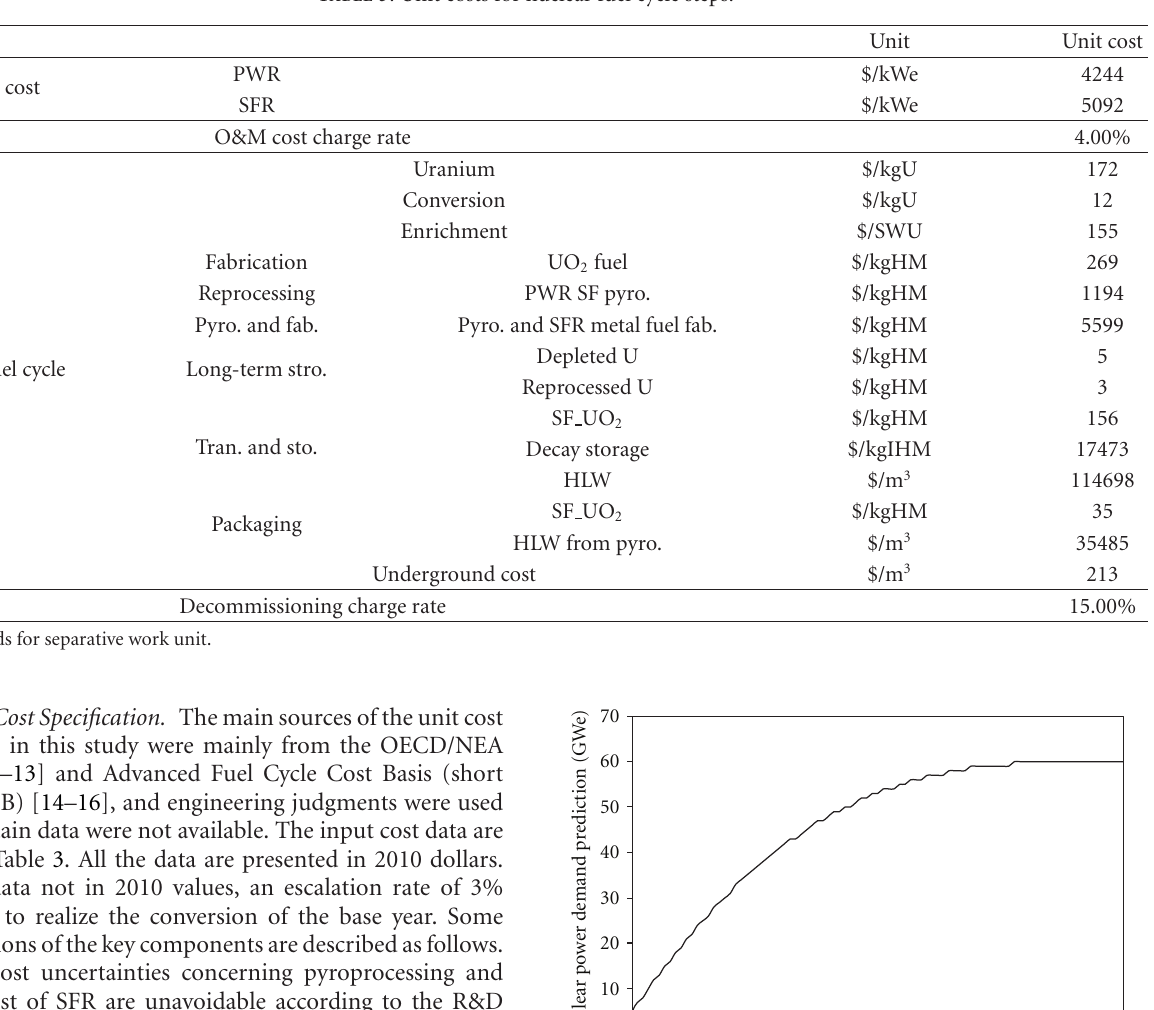
Table 3: Unit costs for nuclear fuel cycle steps.